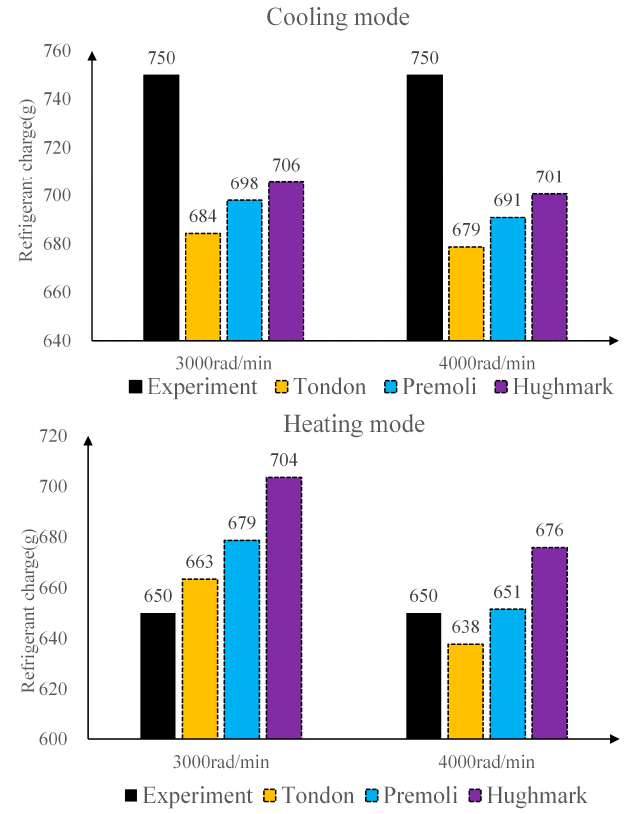
Figure 13. Charge amount theoretical calculations in comparison with experiments .